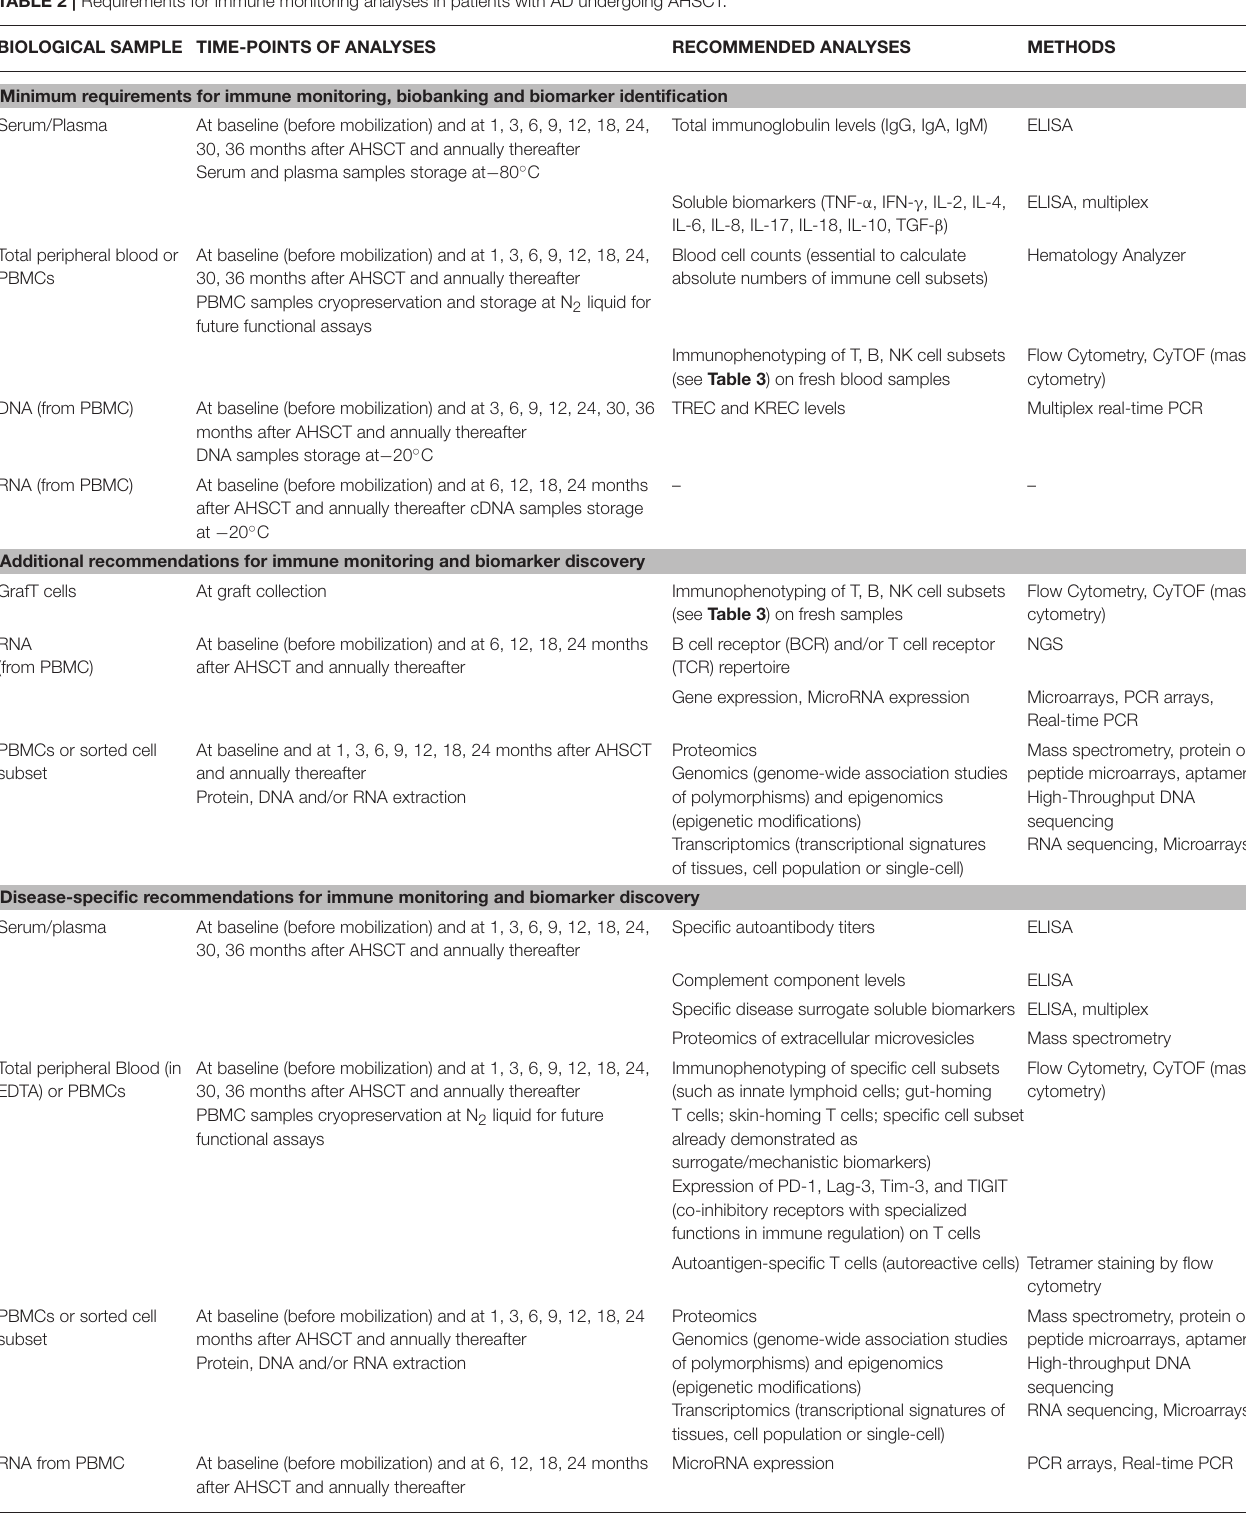
TABLE 2 | Requirements for immune monitoring analyses in patients with AD undergoing AHSCT. BIOLOGICAL SAMPLE TIME-POINTS OF ANALYSES RECOMMENDED ANALYSES